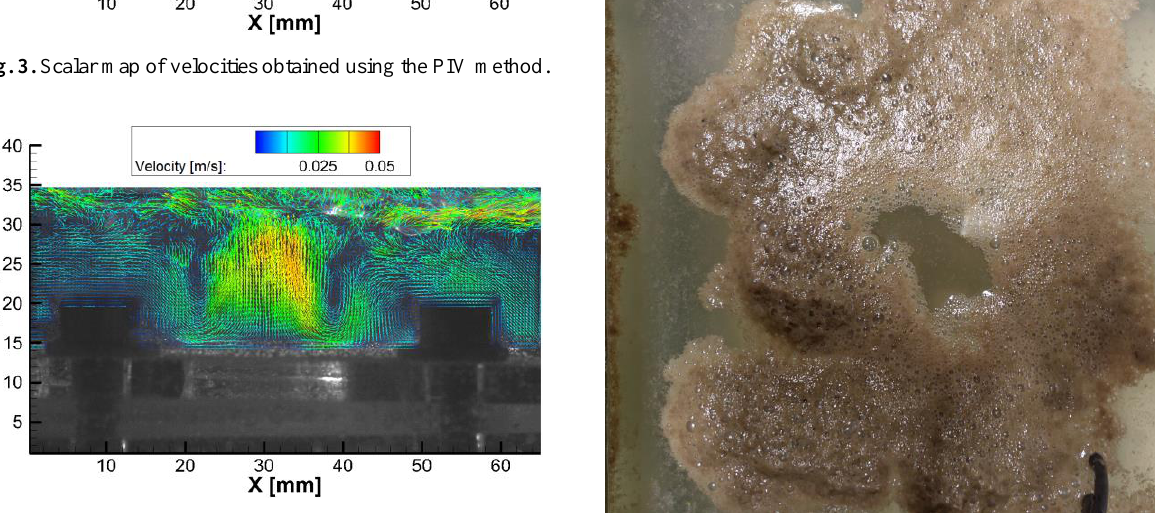
Fig. 4. Vector map of velocities obtained using the PIV method .